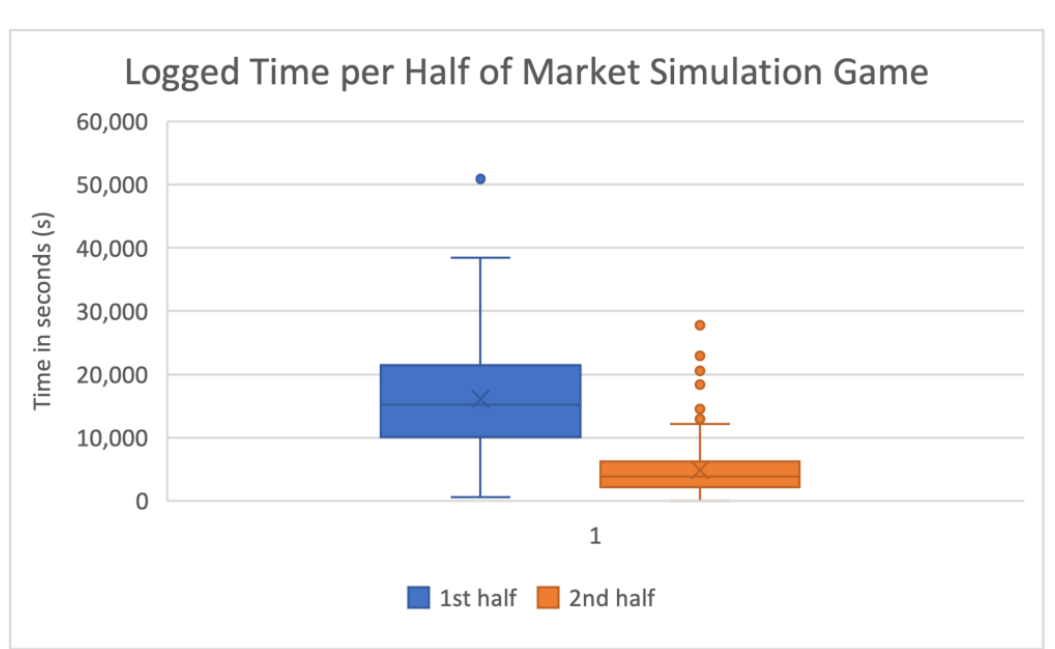
Figure 4. Box plot of logged times for the first and second halves of the market simulation game.